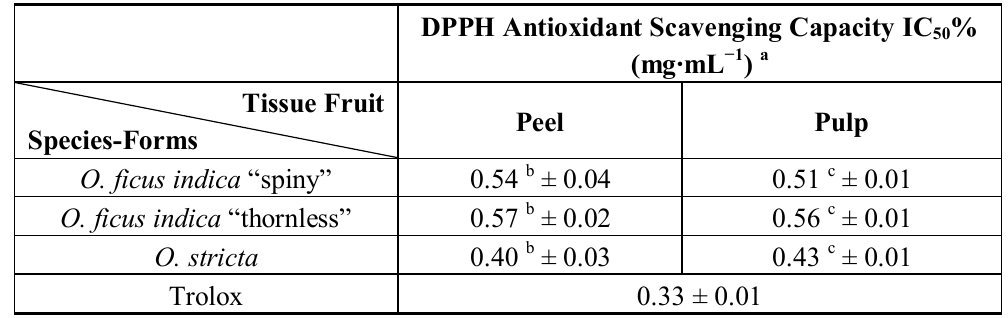
Table 1. DPPH antioxidant scavenging capacity (IC forms and O. stricta fruit methanol extract and